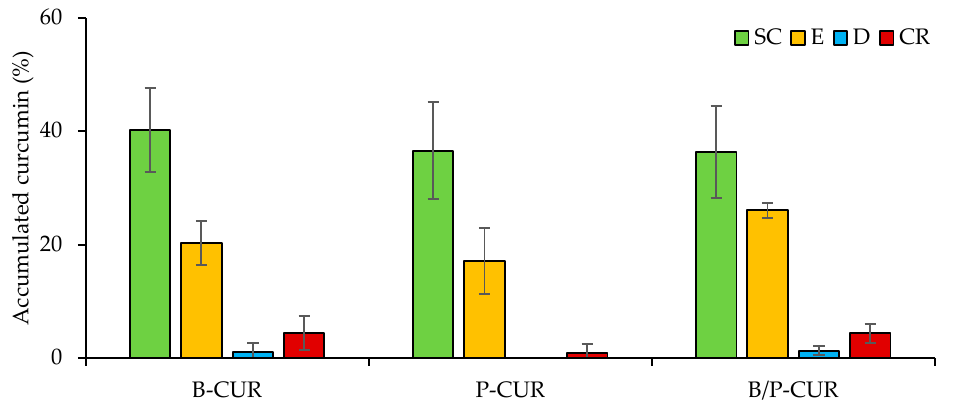
Figure 9. Cumulative amount of curcumin retained in and permeated through the skin layers 24 h after the application of B-CUR, P-CUR, and B/P-CUR hydrogels. The amount of curcumin is expressed as the percentage of the dose applied on the skin (mean values ± s.d.; n = 3).